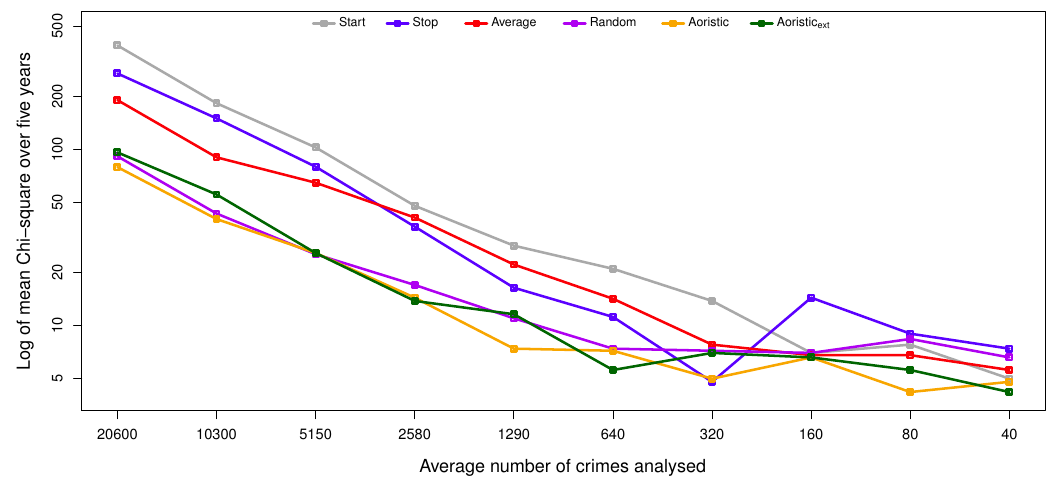
Figure 7. Development of each analysis method with regards to Pearson’s χ 2 measure of the weekday distributions as crimes are repeatedly reduced by 50%. The plot is based on all Swedish burglaries between 2010 and 2014 (N =